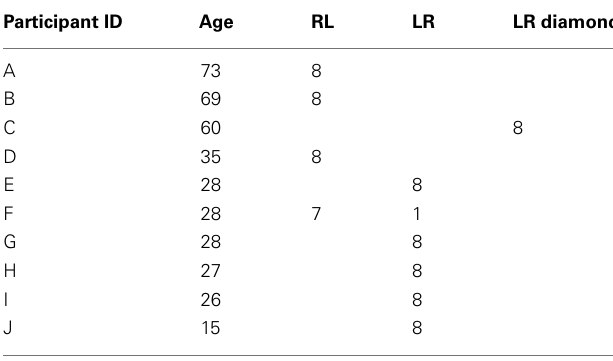
Table 2 | Frequency of arrangement direction in the card arranging task.